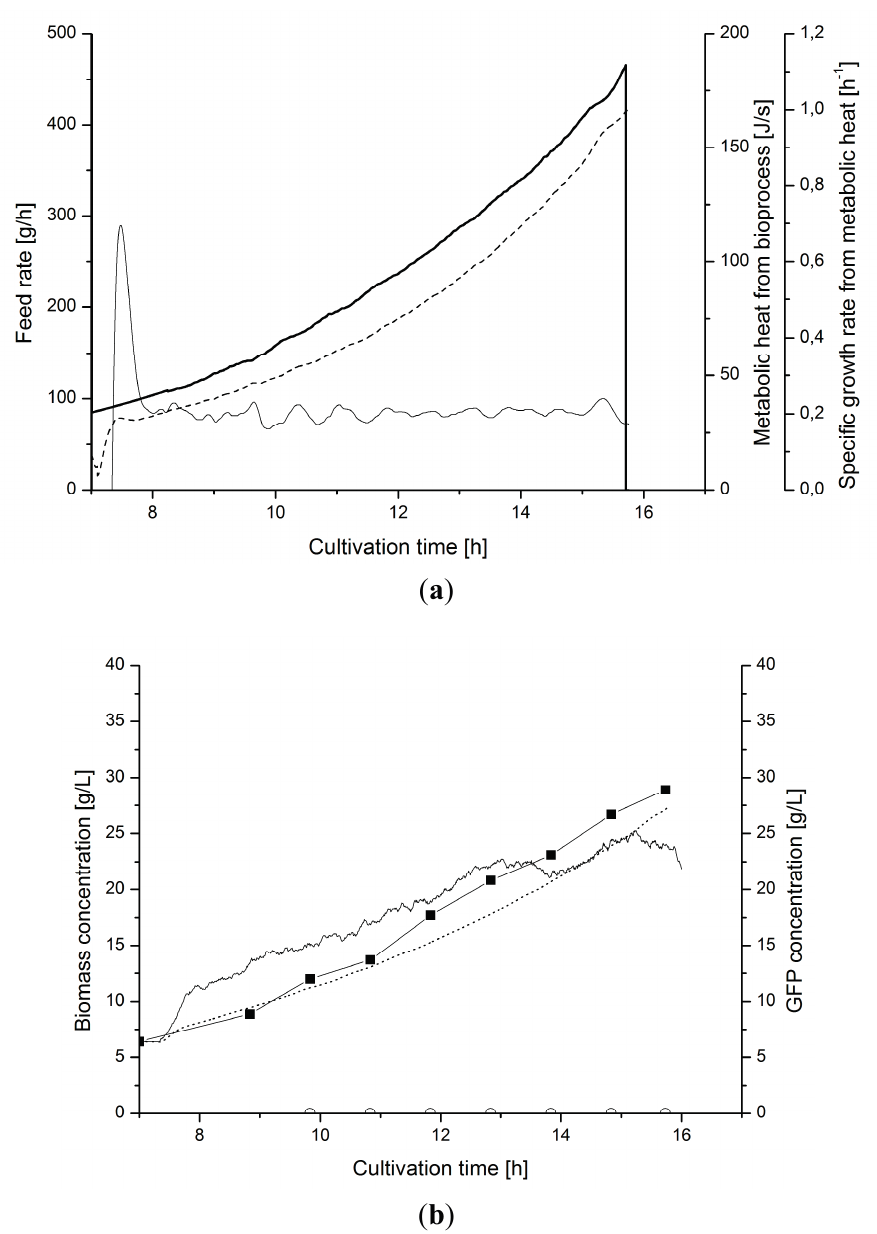
Figure 10. Uninduced fed-batch cultivation. ( a ) Controlled feed rate ( ), metabolic heat production ( ) and µ metabol ( ⎯ ); ( b ) Biomass from heat ( ⋅⋅⋅⋅⋅ ), optical density ( ■ ) and capacitance ( −−− ). GFP ( ○ ) is close to